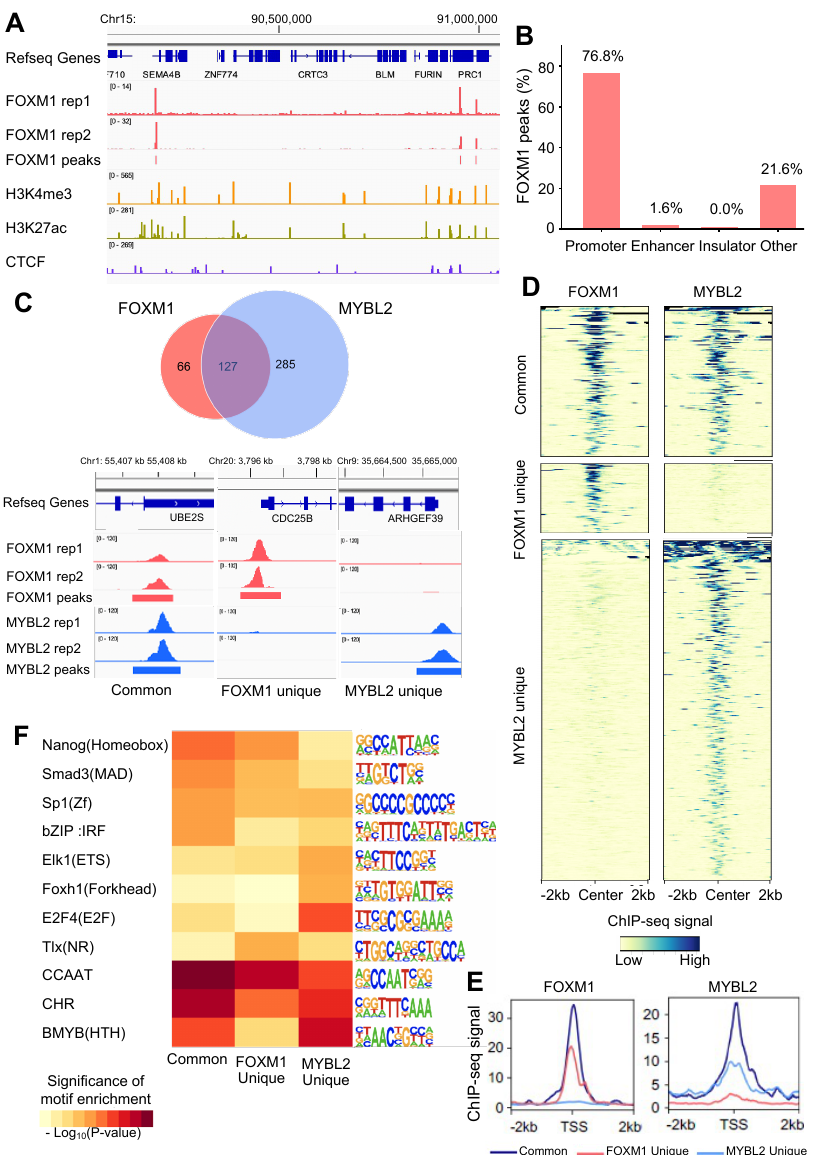
Figure 2. FOXM1 binds to the active promoters bound by MYBL2 in lung adenocarcinoma cells. ( A ) A genome browser screenshot of the chr15q26 region showing two replicates of FOXM1 ChIP- seq signals, IDR-passed FOXM1 peaks, H3K27ac, H3K4me3, and CTCF ChIP-seq signals in A549 cells. ( B ) Genomic distribution of FOXM1 binding sites in A549 cells. ( C ) A Venn diagram of the overlapped binding sites between MYBL2 and FOXM1 ( top ). Example genome browser screenshots of the common ( bottom left ), FOXM1-unique ( bottom middle ), and MYBL2-unique ( bottom right ) binding sites. ( D ) A heatmap showing FOXM1 ( left ) and MYBL2 ( right ) ChIP-seq signals within a 2 kb window of the center of common ( top ), FOXM1-unique ( middle ), and MYBL2-unique ( bottom ) binding sites. The ChIP-seq signals are indicated by the color from yellow ( low ) to blue ( high ). ( E ) The average ChIP-seq signals of FOXM1 ( left ) and MYBL2 ( right ) at common (dark blue), FOXM1-unique (red), and MYBL2-unique (light blue) binding sites located within a 2 kb window of the transcription start sites (TSS). ( F ) A heatmap showing the most enriched motifs found in either common ( left ), FOXM1-unique ( middle ) or MYBL2-unique ( right ) binding sites. The motif analysis is performed using the 100 bp window around the ChIP-seq peak summits. Shown to the right are the sequence logos of the motifs. The statistical significance of each motif enrichment of motifs is indicated by a color gradient from yellow ( low ) to dark red ( high